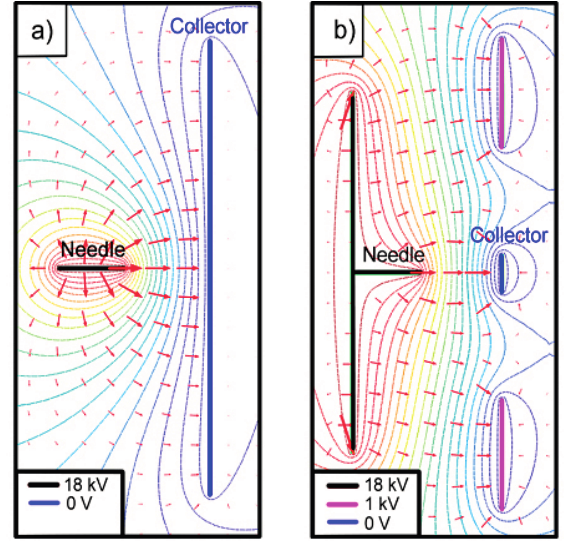
Figure 1. Simulation, using the software Comsol, of the equipotential lines and the direction and intensity of the electric field in the structures described above. ( a ) Usual electrospinning; ( b ) Focused setup used in this